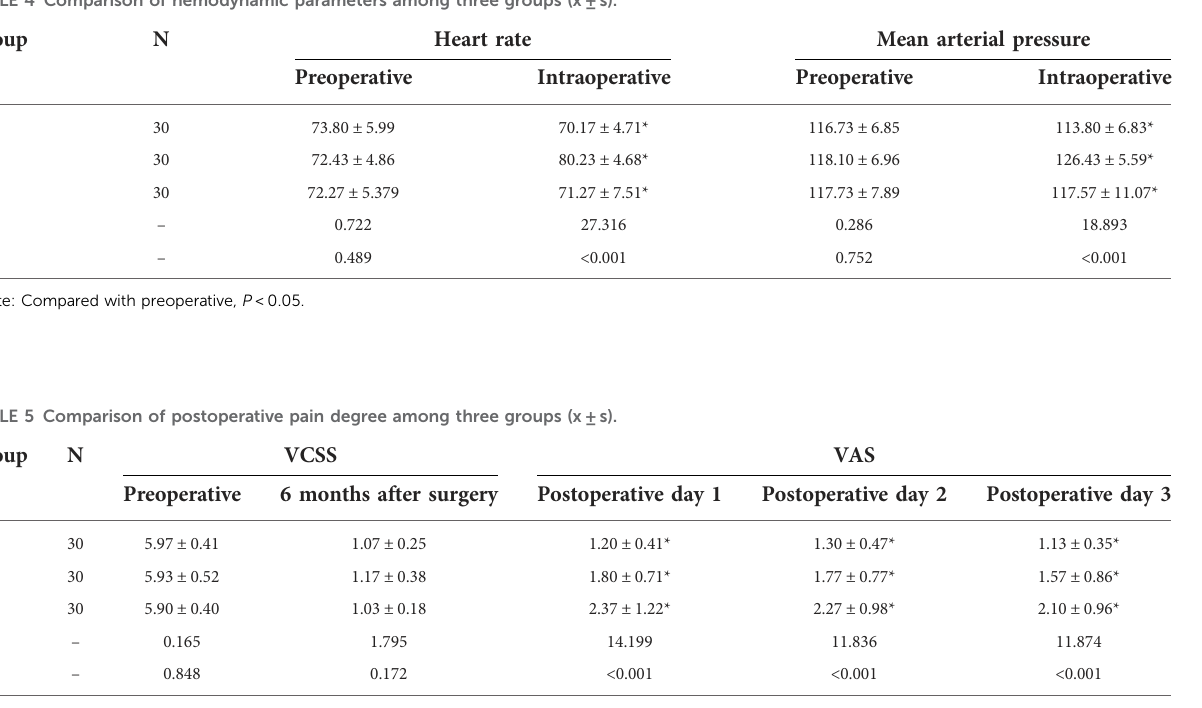
Table 3 . The postoperative complications of the three groups were effectively relieved after symptomatic treatment (dressing change, anti-infection, taking drugs to improve circulation, etc.).